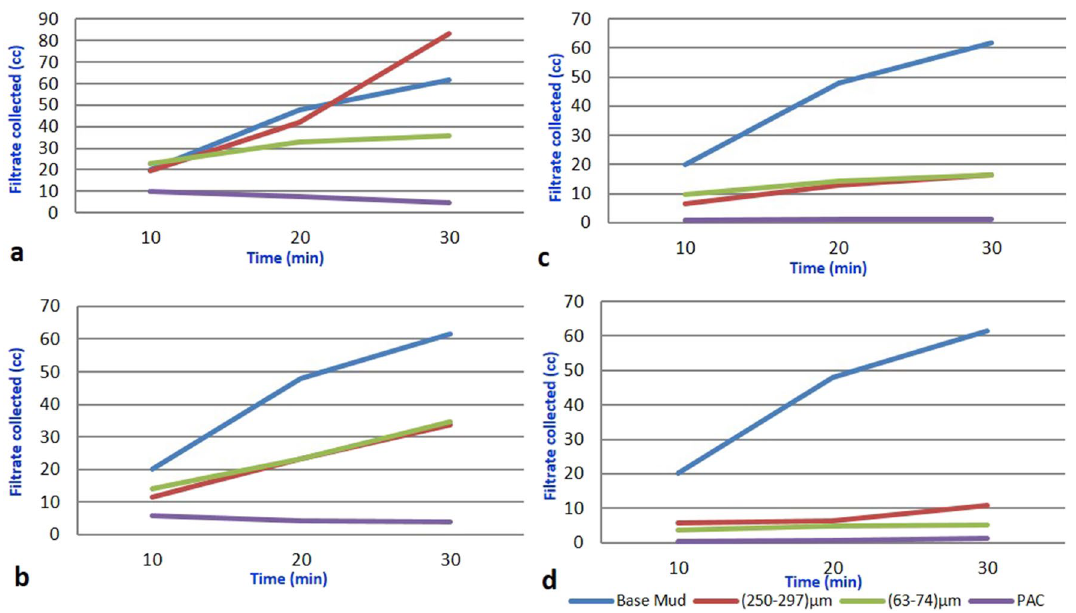
Fig. 10 API filtration losses of developed drilling fluid formulations after hot roll a at 1% sample concentration, b at 2% sample concentration, c At 3% sample concentration, d at 4% sample concentration